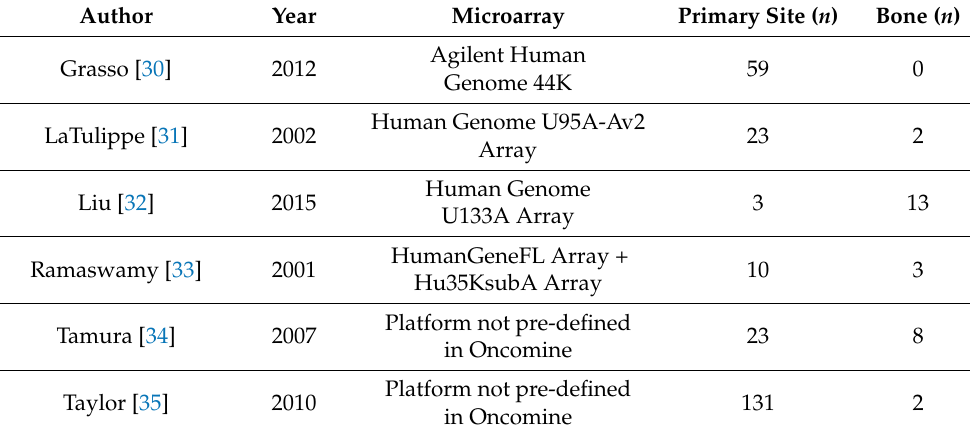
Table 1. Main characteristics of studies included in